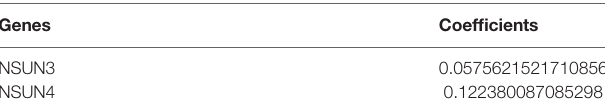
TABLE 3 | Genes selected to build risk signature and the corresponding coef fi cients. Genes NSUN3